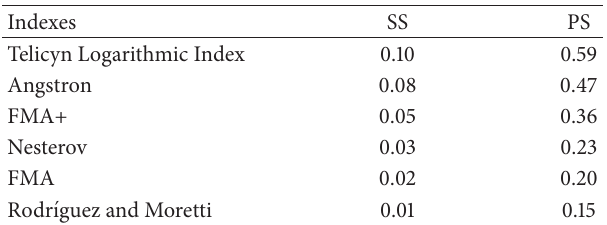
Table 3: Values of the Skill Score and Percentage of Success for the Fire Danger Indexes evaluated in the study